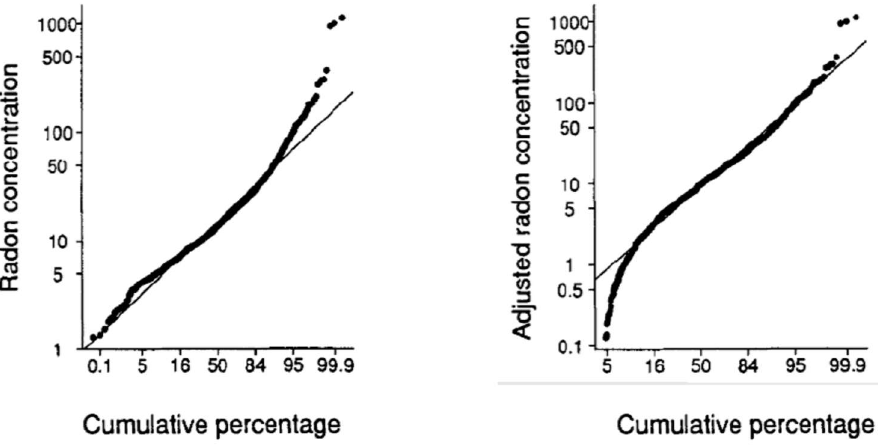
Figure 1. Uncorrected ( left figure ) and corrected ( right figure ) cumulative distribution of log of indoor radon concentration. Figure is taken from [55,56].